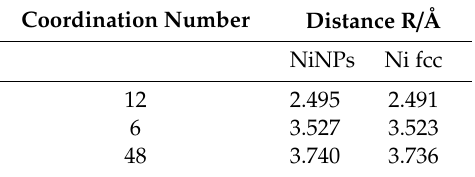
Table 1. Comparison of the fitted EXAFS data of the NiNPs with the structural parameters of fcc Ni.